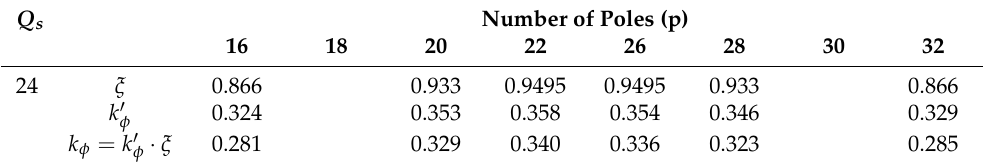
Table 2. Number of poles with ξ > 0.866 for a stator with 24 slots.